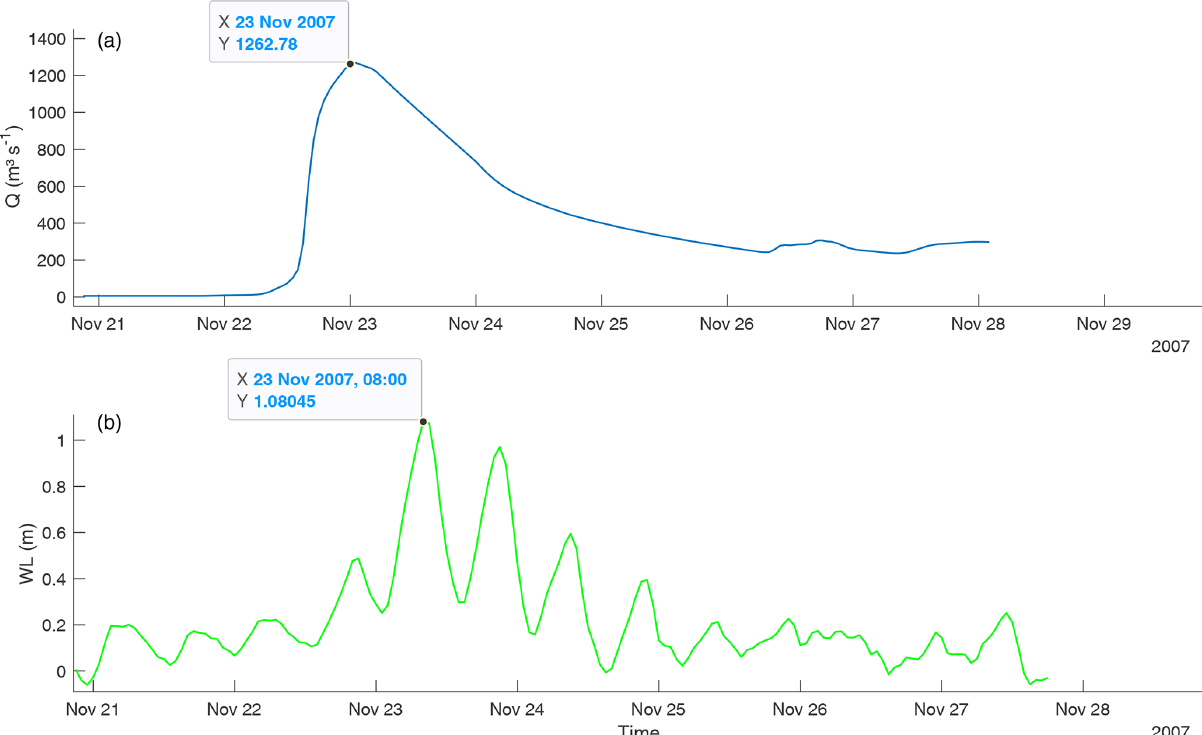
Figure D3. Validation event (22–25 November 2007) of river discharge at the flow gauge Swellendam (a) and of the NTR at the tide gauge in Witsand (b) ; between both peaks we estimated a time lag of 8h.